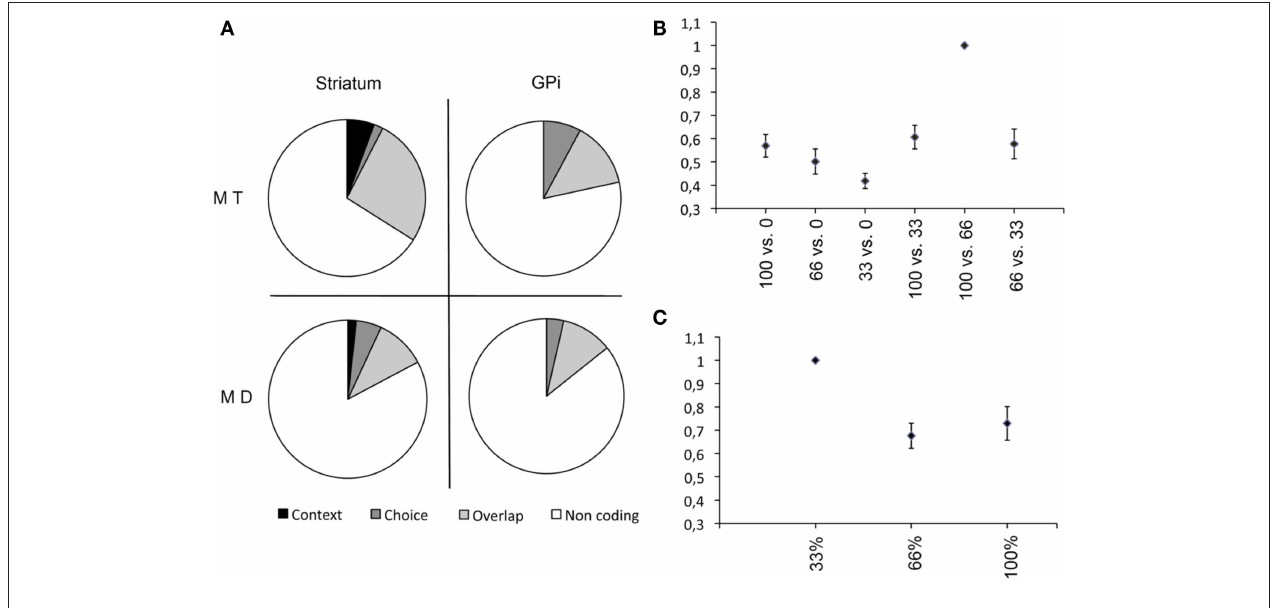
Figure 5 | results of the coding neurons extraction. (A) Coding distributions regarding context or choice values for both monkey T ( N = 53 for striatum and 51 for GPi) and monkey D (respectively N = 58 and 56). Overlap indicates neurons coding for both context and choice. (B) Three